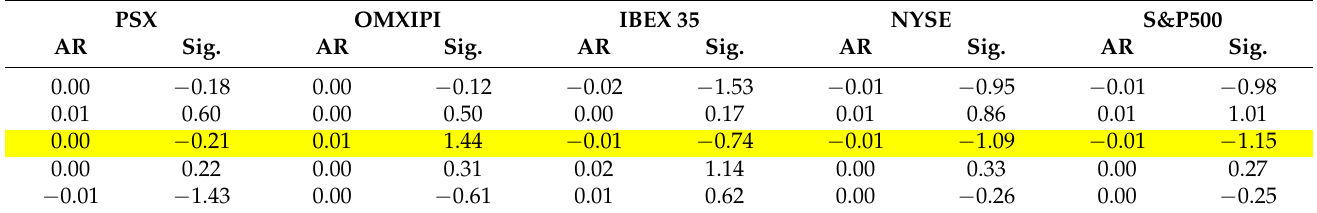
Table A25. Abnormal returns of the ( − 2, +2) event window (Jurgen Mossack Resignation).